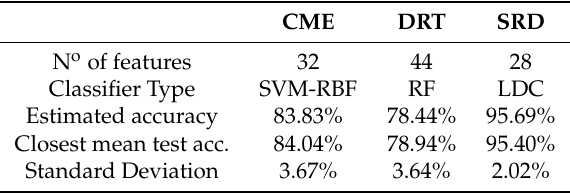
Table 2. Final results for each type of ME and chosen